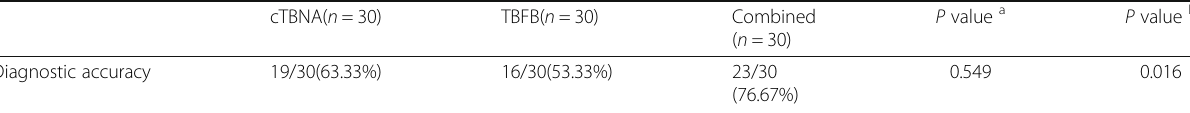
Table 5 Diagnostic rate of cTBNA and TBFB in the paired design